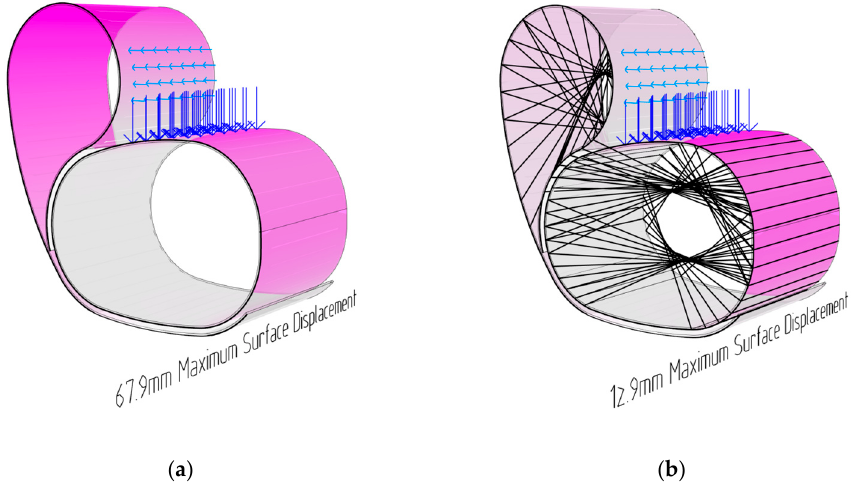
Figure 23. Timber surface displacement finite element analysis: ( a ) the unreinforced model; ( b ) the flax FRP-reinforced model.